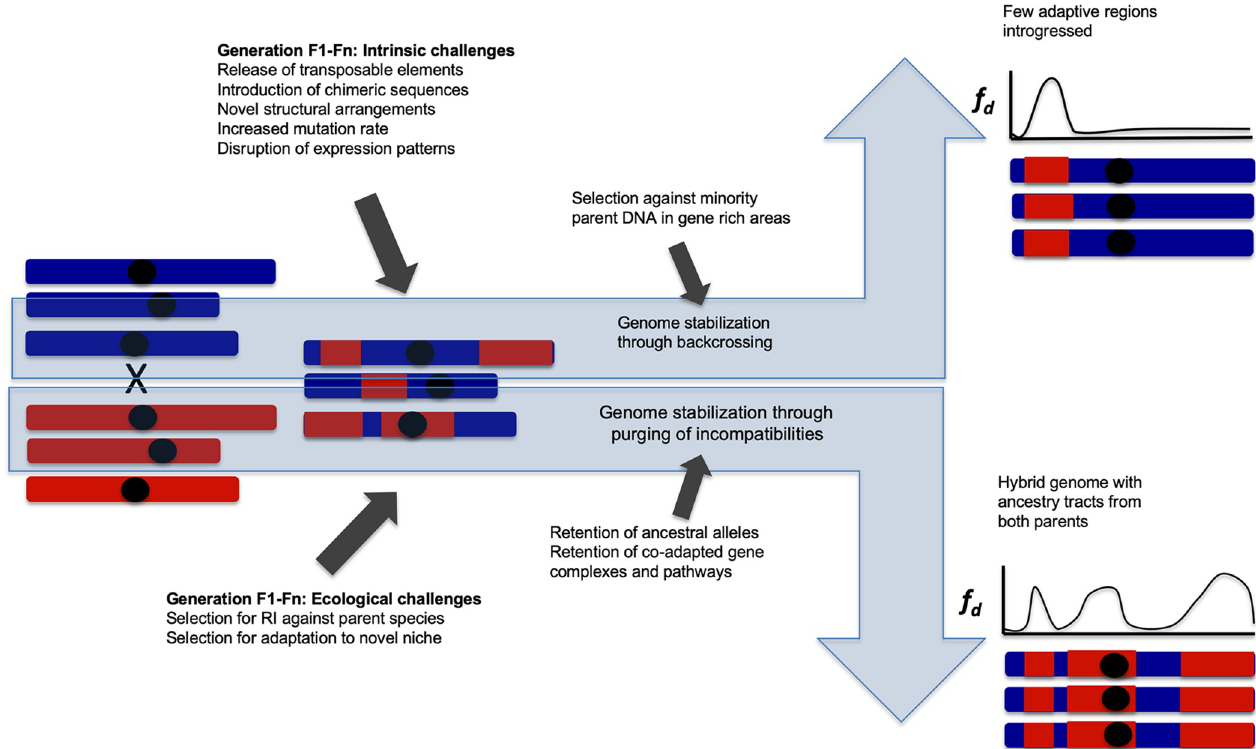
Fig 3. The process of genome stabilization during hybrid speciation and introgression. Both ecological selection pressures and selection to avoid intrinsic incompatibilities mould hybrid genomes. Depending on the balance between beneficial alleles and incompatibilities hybridisation can result either in an admixed taxon that is reproductively isolated from both parent taxa, or local introgression into a taxon that remains distinct in spite of occasional gene flow. RI abbreviates reproductive isolation. Fd is a measure of introgression and is estimated between a hybrid population and the red parent species, and the haplotypes illustrate example individuals in these